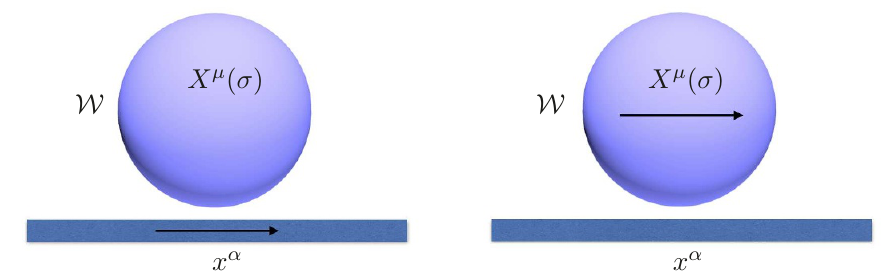
Figure 1 . Schematic representation of the two variational methods for the surface W . The figure on the left corresponds to method (1) , where the background coordinates x α are displaced while the embedding map X µ is kept fixed. The figure on the right corresponds to method (2) where the background coordinates are kept fixed and the embedding map is displaced. The first method can be thought of displacing a “mat” (background) underneath the surface while the second can be thought of displacing the surface above the